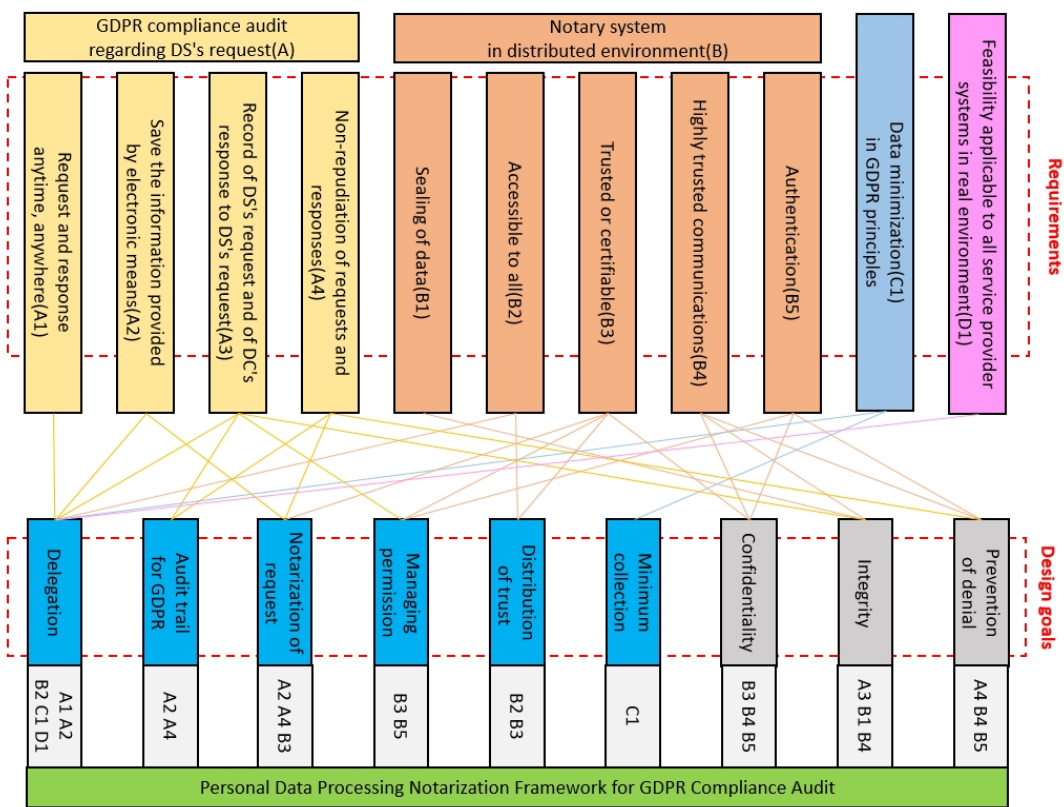
Figure 5. Notarization framework design goals.